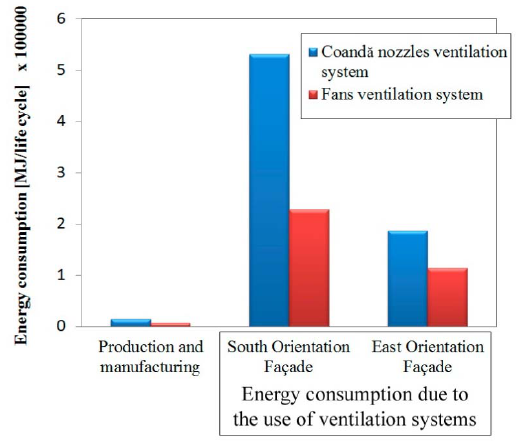
Figure 13. Total energy consumption over the 25 year life